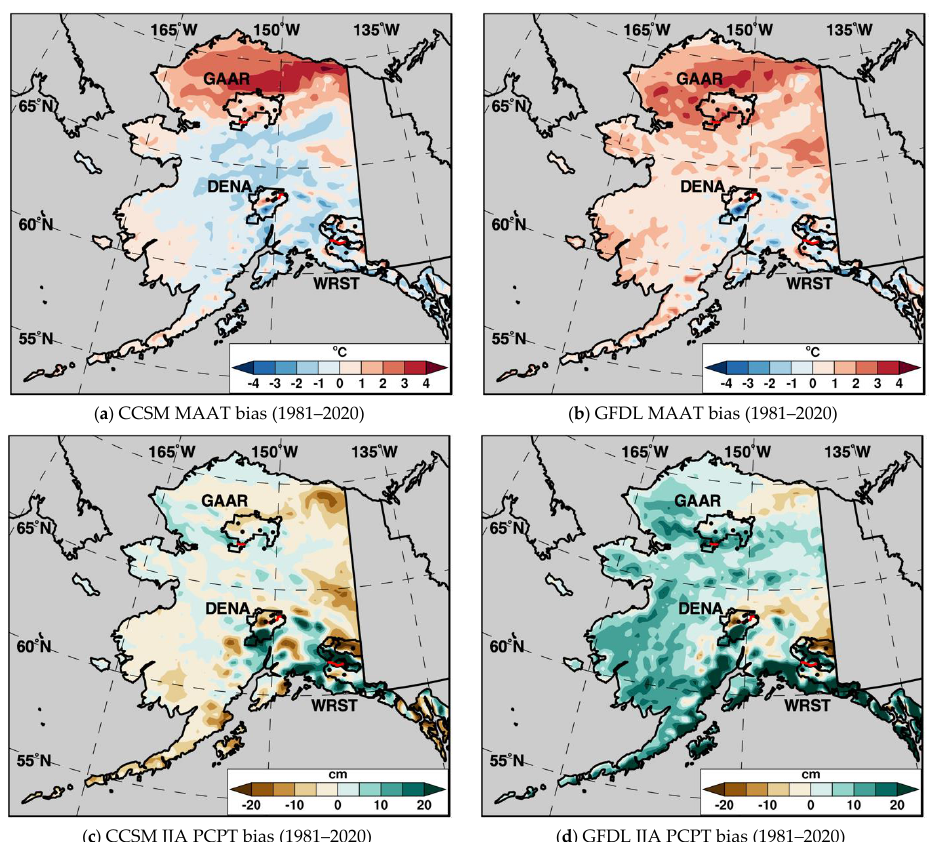
Figure 5. Historical ( a ) CCSM and ( b ) GFDL mean annual air temperature (MAAT) bias (°C), and ( c ) CCSM and ( d ) GFDL summer precipitation (JJA PCPT) bias (cm). Biases are relative to the ERA5 MAAT and JJA PCPT climatologies, respectively.